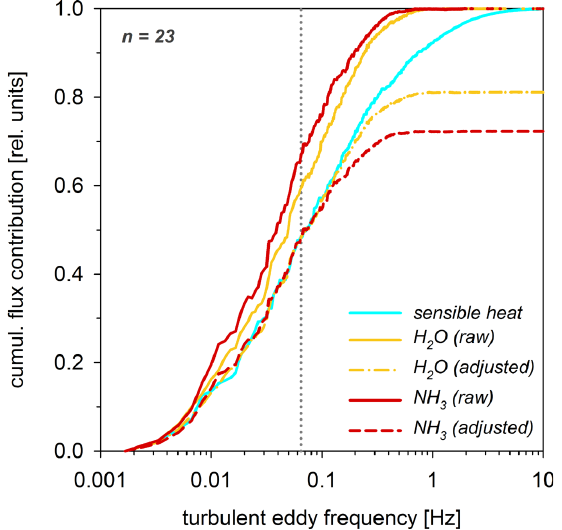
Fig. 7. Normalised median ogives of sensible heat, H 2 O and NH 3 flux on 6 August 2009, 11:10–15:00; U =1.47 ± 0.5ms − 1 , (z − d)L − 1 =− 0 . 47 ± 0 . 3; illustrating the effect of high-frequency damping on NH 3 and H 2 O flux: dashed lines represent the ogives of the dampened fluxes adjusted to the ogive of the sensible heat fluxes at a threshold frequency of 0.065Hz (dotted line).